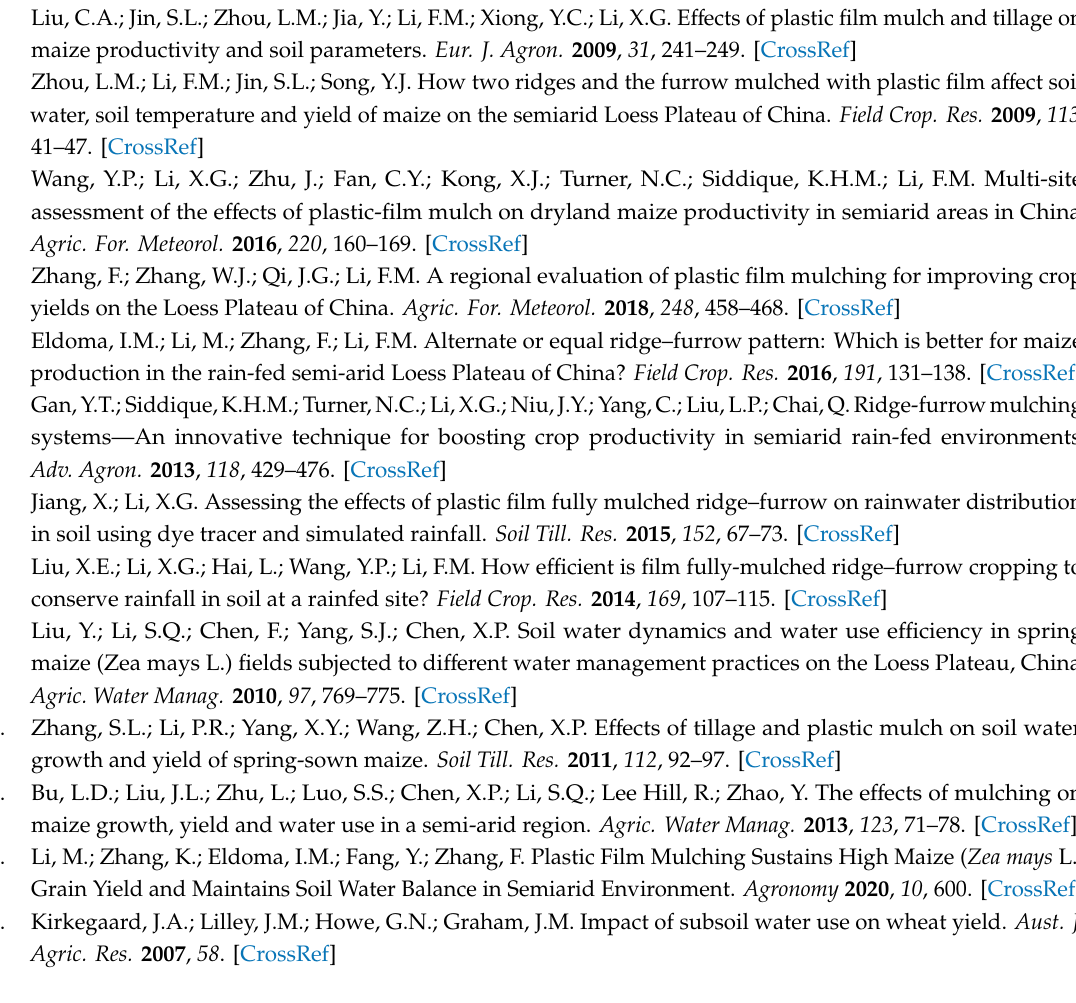
Figure S1: Cross-sectional views of planting patterns of (a) check (CK) and (b) plastic film mulching (PM) treatment; Figure S2: Soil water storage within the 0 to 200 cm soil layer in mulched (PM) and check (CK) plots in (a) 2014 and (b) 2015. Vertical bars represent standard errors of the